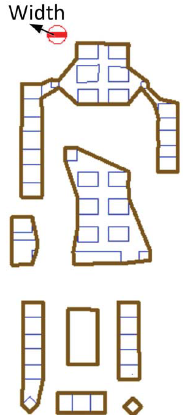
Figure 9. Resulting non-overlapping boundaries of obstacle